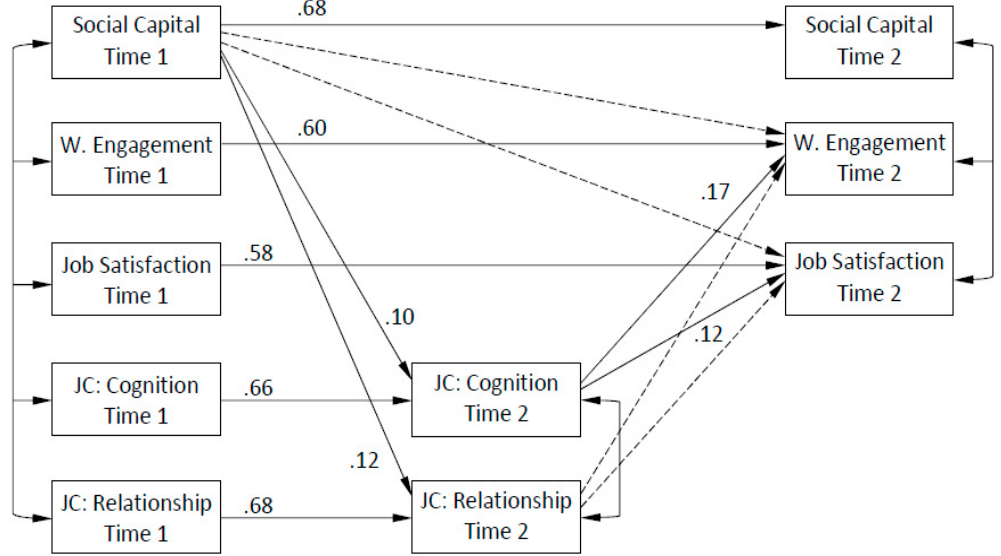
Figure 2. Mediation model (where W. means work, and JC means job crafting). Dashed lines indicate that the relationship was not significant at p < 0.05. Table 3. Standardized estimates and p -values for concurrent variance in the mediation model.